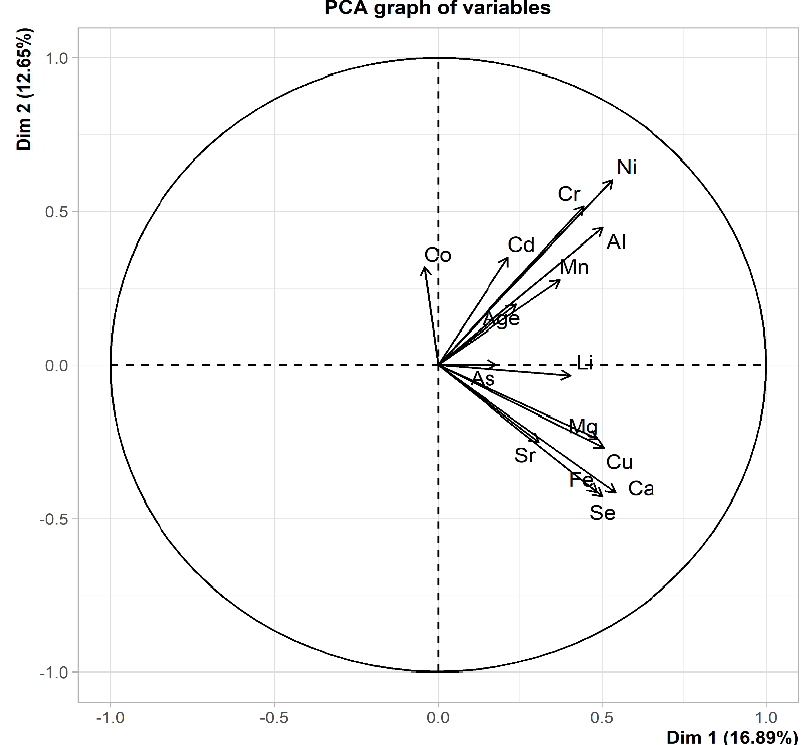
Figure 4. Correlation chart showing the relationships between the examined parameters: Mn, Al, Ni, Cr, Cd, Fe, Mg, Cu, Ca, Se Sr, Co, As, Li, and Age; the relationships are presented in the system of the first two principal components Dim 1 and Dim 2. These two components are a combination of all the tested